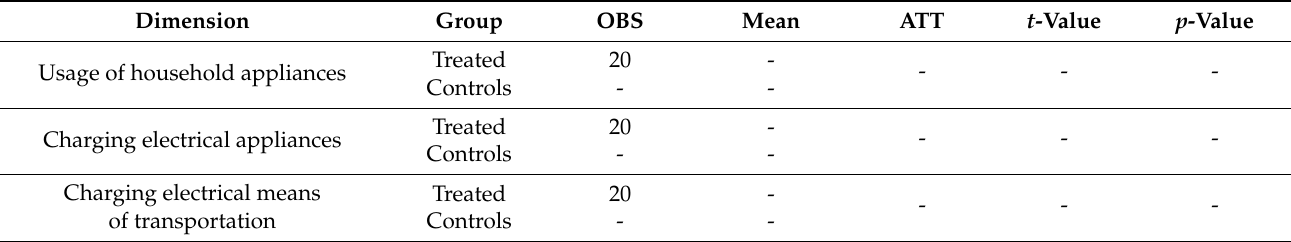
Table 6. Demand flexibility comparisons of Wind-owners (treated) versus Biogas-owners (controls) (source: authors’ own